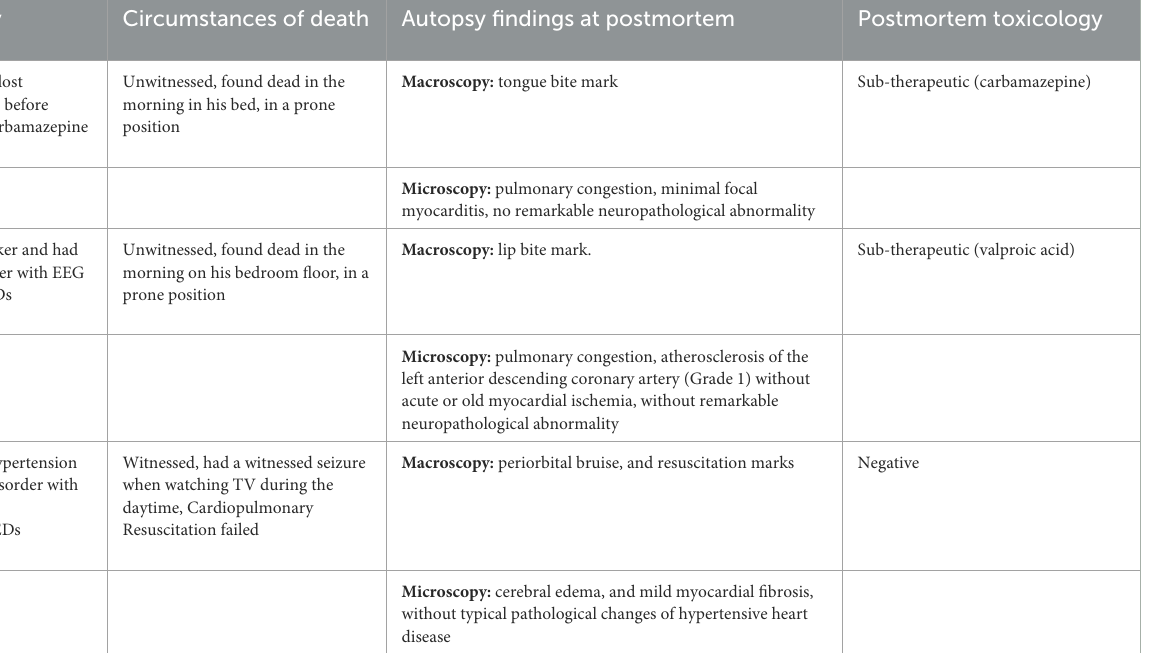
TABLE 1 Basic characteristics and autopsy findings of the three sudden unexpected deaths in epilepsy (SUDEP)